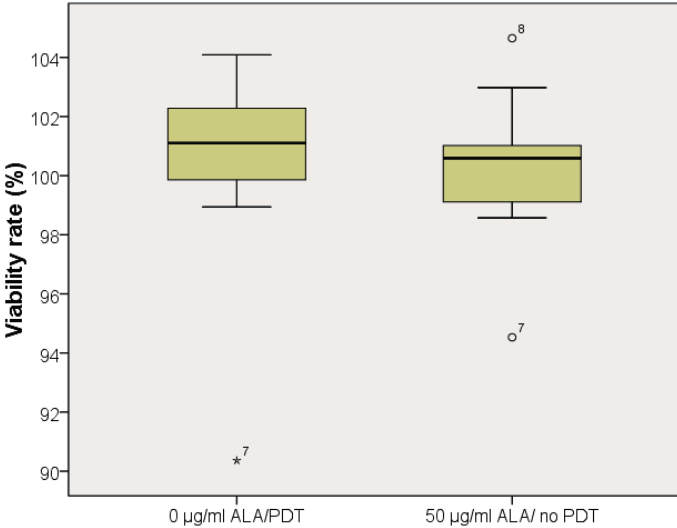
Figure 2. Negative controls; note: outliers (>1 standard deviation) were marked by stars or